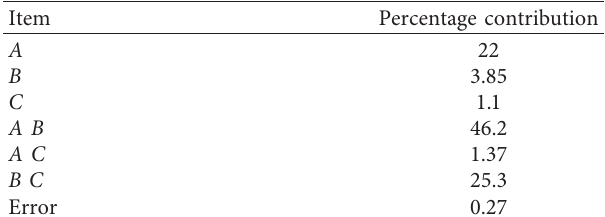
Figure 8: Residual plots for vibration (volt). Table 5: Percentage contribution for